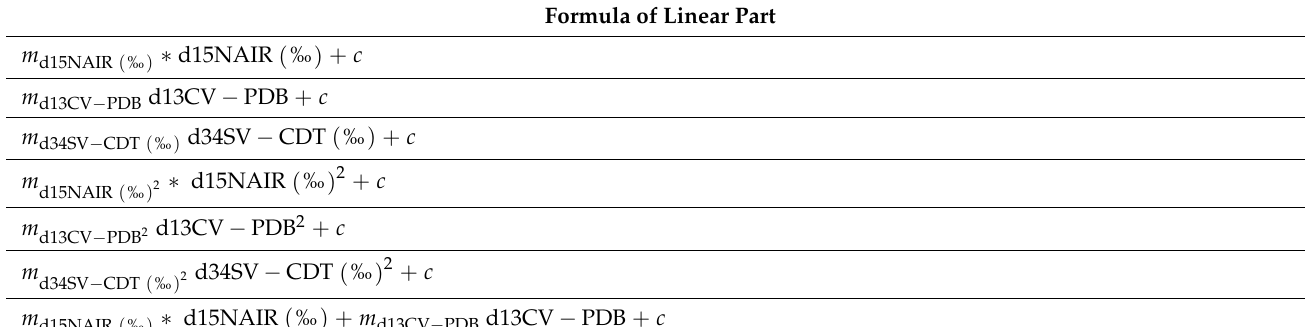
Table A1. List of different linear combinations that are used in the likelihood function of the proposed generic